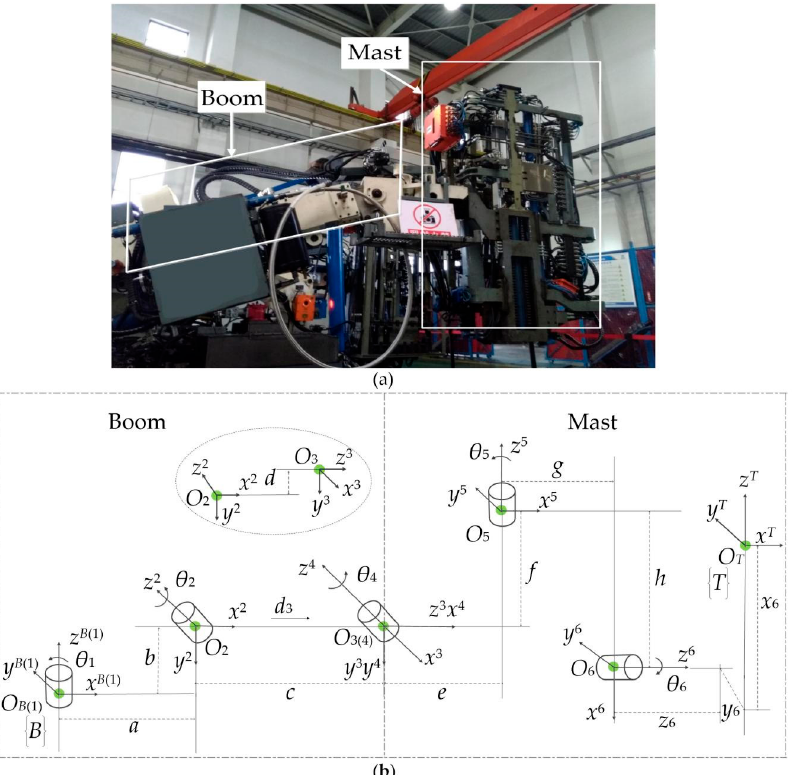
Figure 1. A typical airborne heavy-duty mechanical arm: ( a ) the heavy-duty mechanical arm of a roof bolter; ( b ) the kinematics model of the airborne heavy-duty mechanical arm.